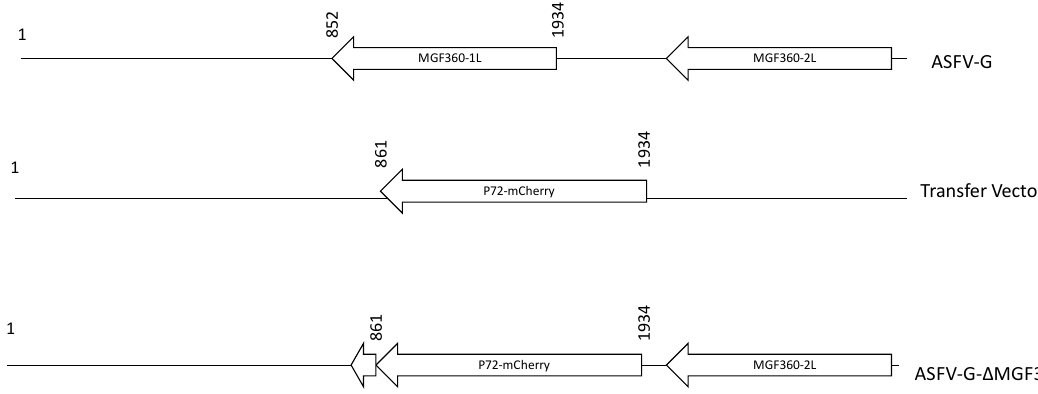
Figure 3. Schematic for the development of ASFV-G- ∆ MGF360-1L. The transfer vector contains the p72 promoter and a mCherry cassette; the flanking left and right arms are designed to have flanking ends to both sides of the deletion / insertion cassette. The resulting ASFV-G- ∆ MGF360-1L with the cassette inserted is shown on the bottom with the residual 10 amino acids of MGF360-1L, which are unlikely to be transcribed, as indicated by the shortened arrow. The nucleotide positions shown are relative to the parental virus.